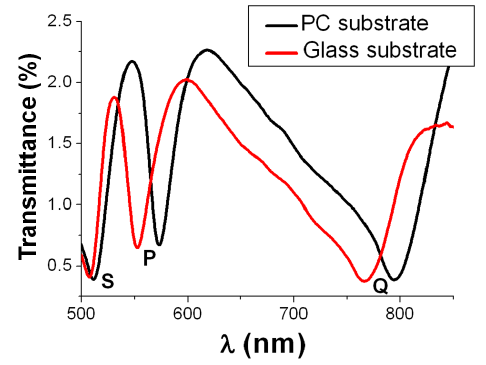
Figure 3. Experimental spectral transmittance of 500-nm-period Al NHAs on polycarbonate and glass substrates. The spectra exhibit three similar transmission minima: S-wavelength is associated to the superstrate (air)/metal interface SPP resonance, whereas P- and Q-wavelengths are related to substrate/metal SPP resonances.